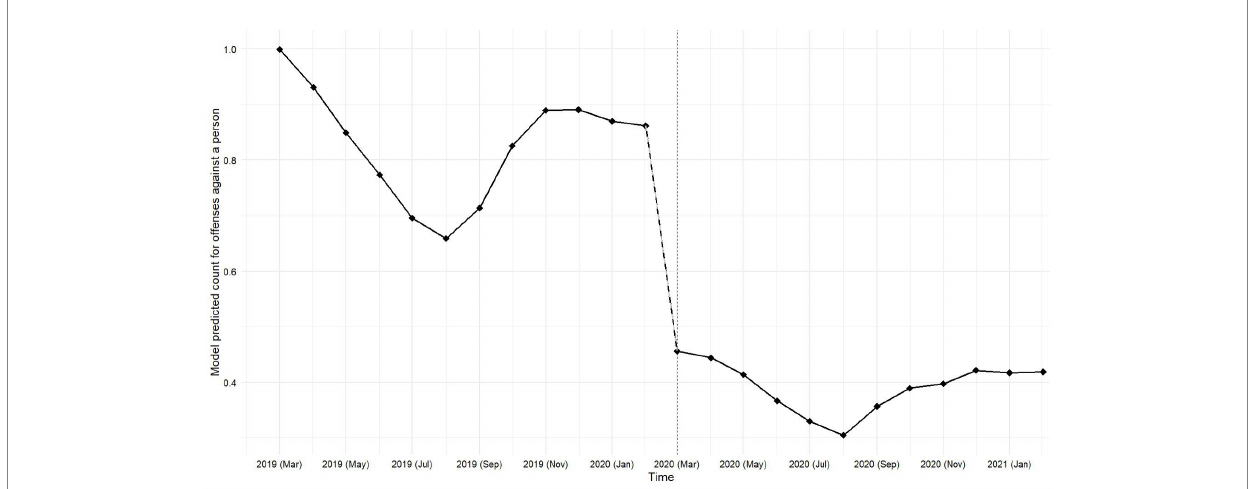
FIGURE 2 Model predicted counts for offenses against a person prior to, at, and following the COVID-19 pandemic by taking seasonality into account. The X-axis represents months prior to (March 2019 to February 2020), at (March 2020, the vertical dashed line), and following (April 2020 to February 2021) the school closures. Y-axis represents the model predicted mean count. The dashed vertical line indicates the month when containment measures started to be implemented. The dashed oblique line highlights the abrupt jump in offense count between 1 month before the implementation of the containment measures and the month after implementing these containment measures.